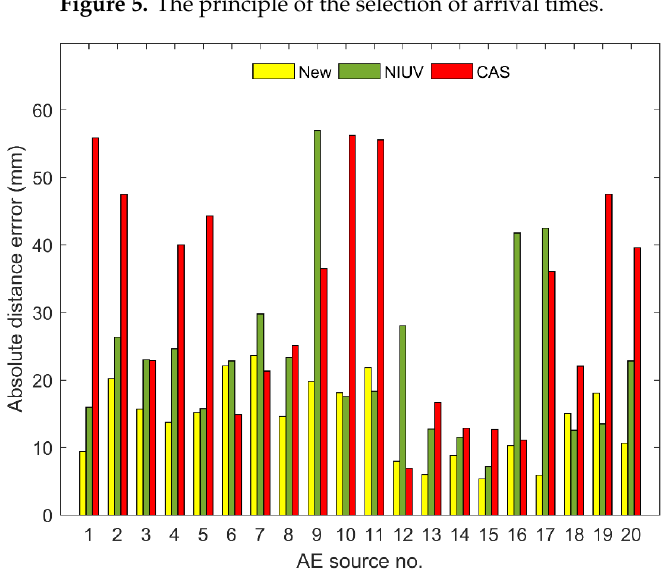
Figure 5. The principle of the selection of arrival times. Sensors 2020 , 20 , x FOR PEER REVIEW